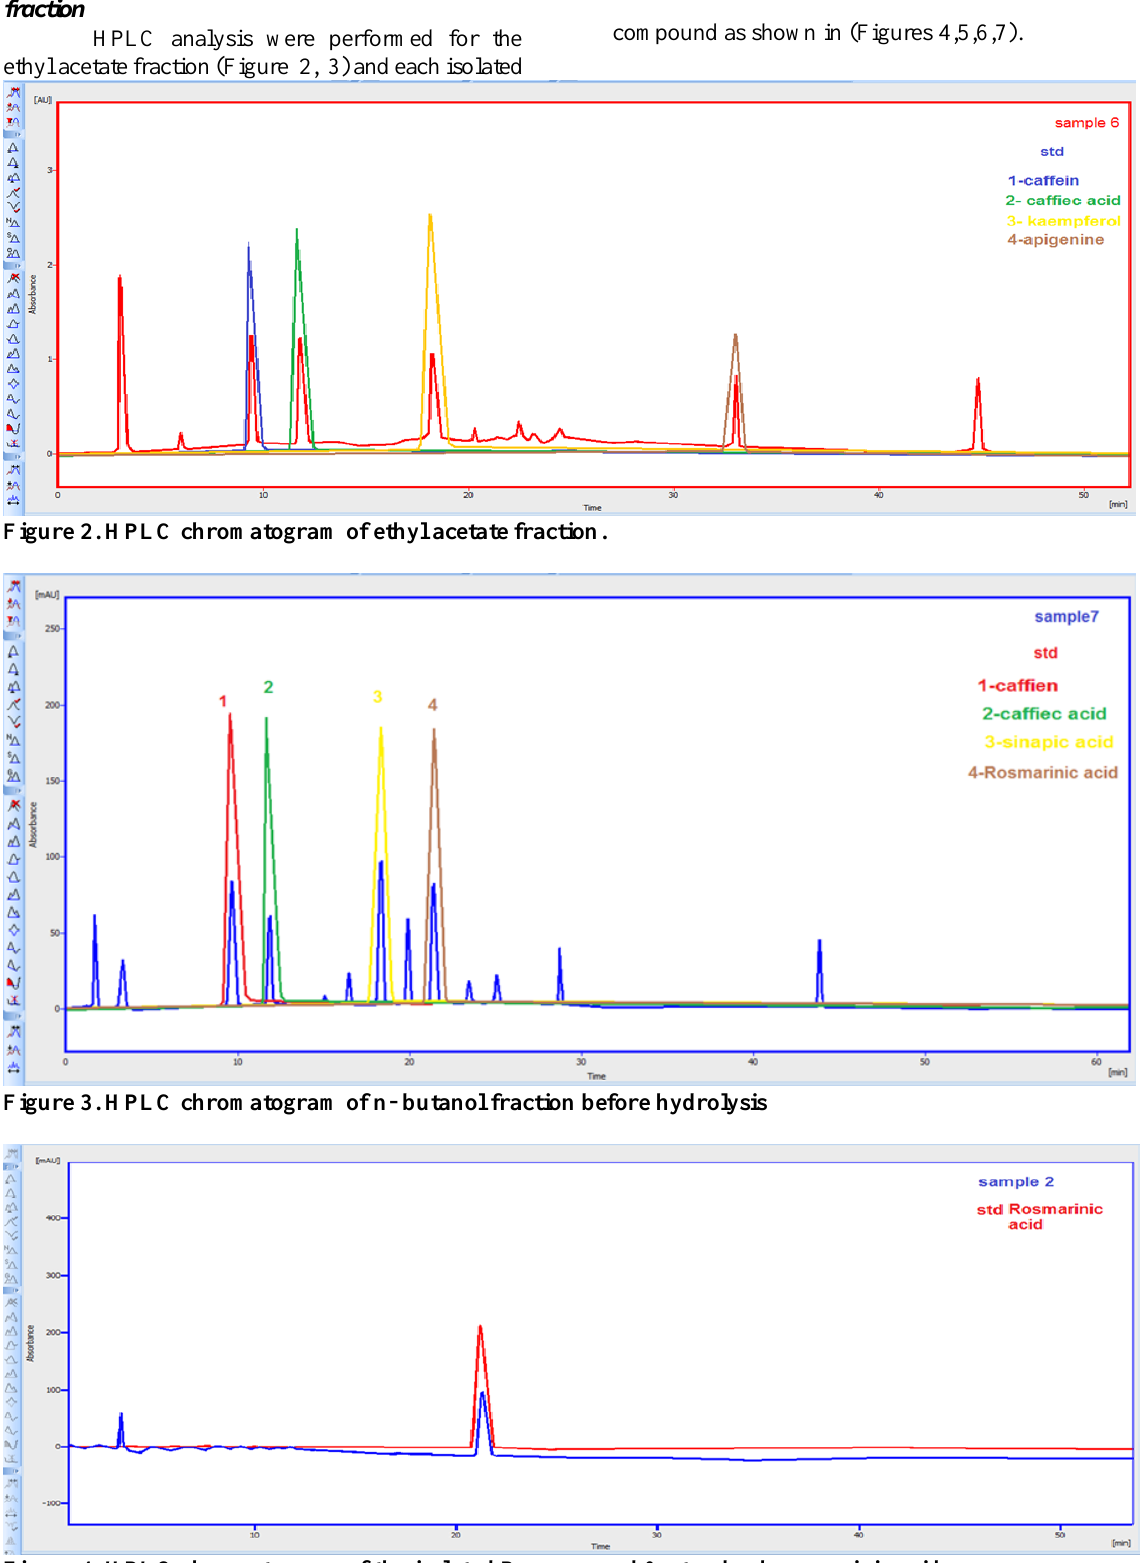
Figure 4. HPLC chromatogram of the isolated R compound & standard rosmarinic